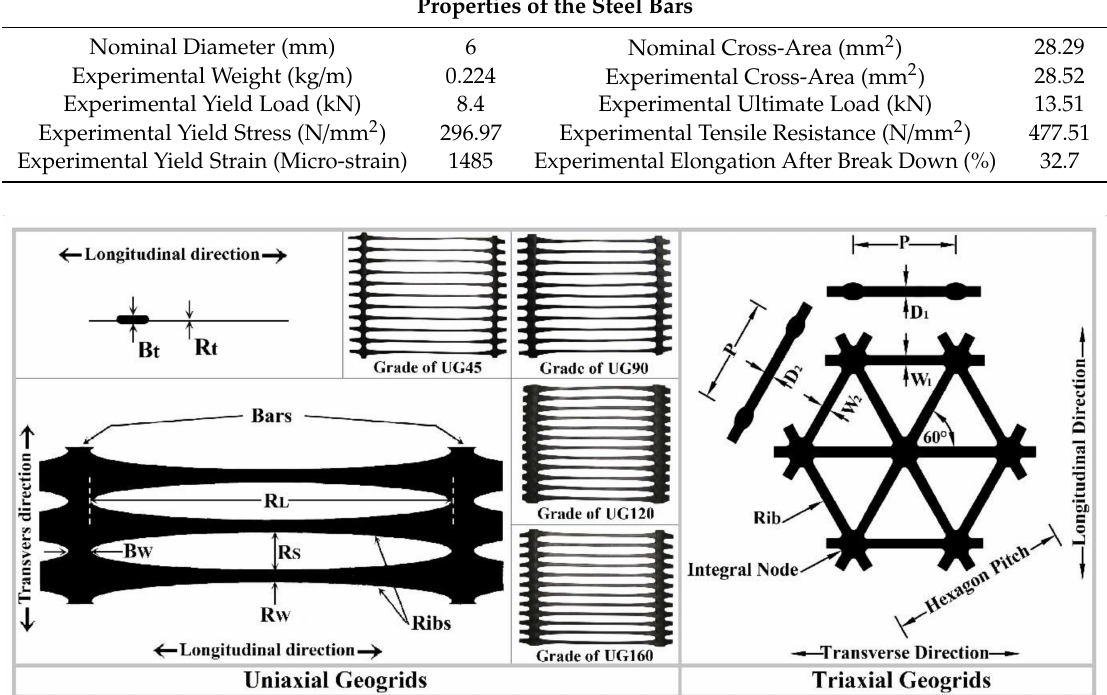
Figure 1. Dimensional characteristics of uniaxial geogrids and triaxial